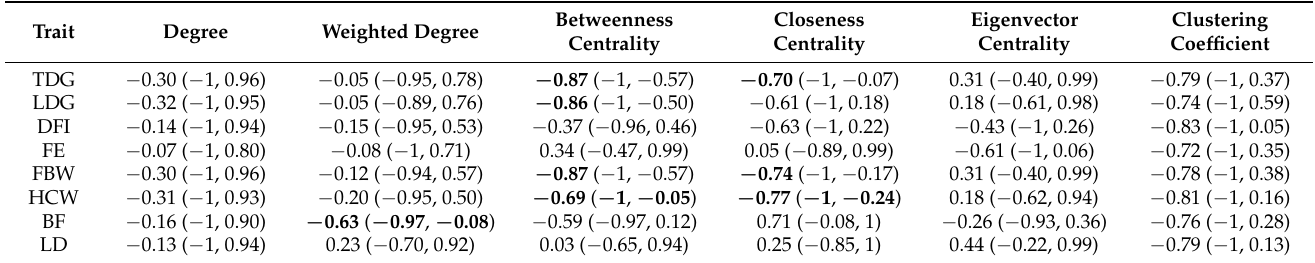
Table 5. Posterior means of the genetic correlations and the 95% highest posterior density intervals (HPD95%) between social network analysis traits and performance traits 1